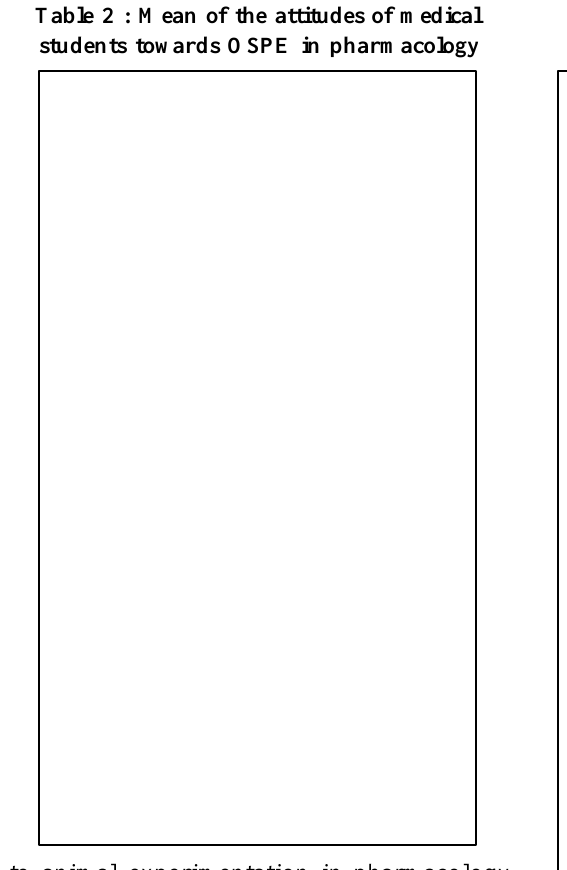
Table 3 : Gender analysis of students' attitudes towards OSPE in